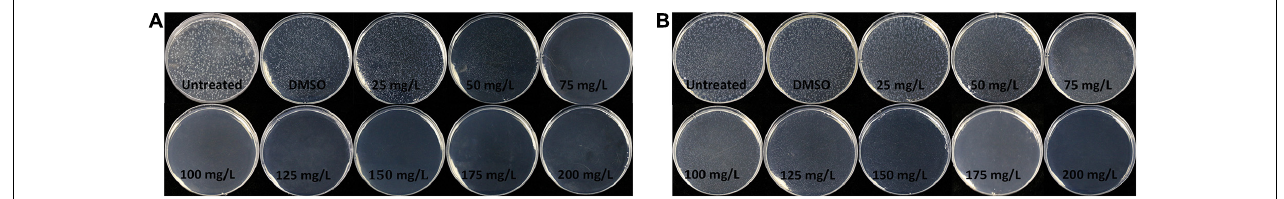
FIGURE 1 | The minimum inhibitory concentration (MIC) and minimal bactericidal concentration (MBC) of 7-methoxycoumarin on R. solanacearum was determined using the agar dilution method at the concentrations ranging from 25 to 200 mg/L. (A) 48 h after inoculation. (B) 96 h after inoculation.